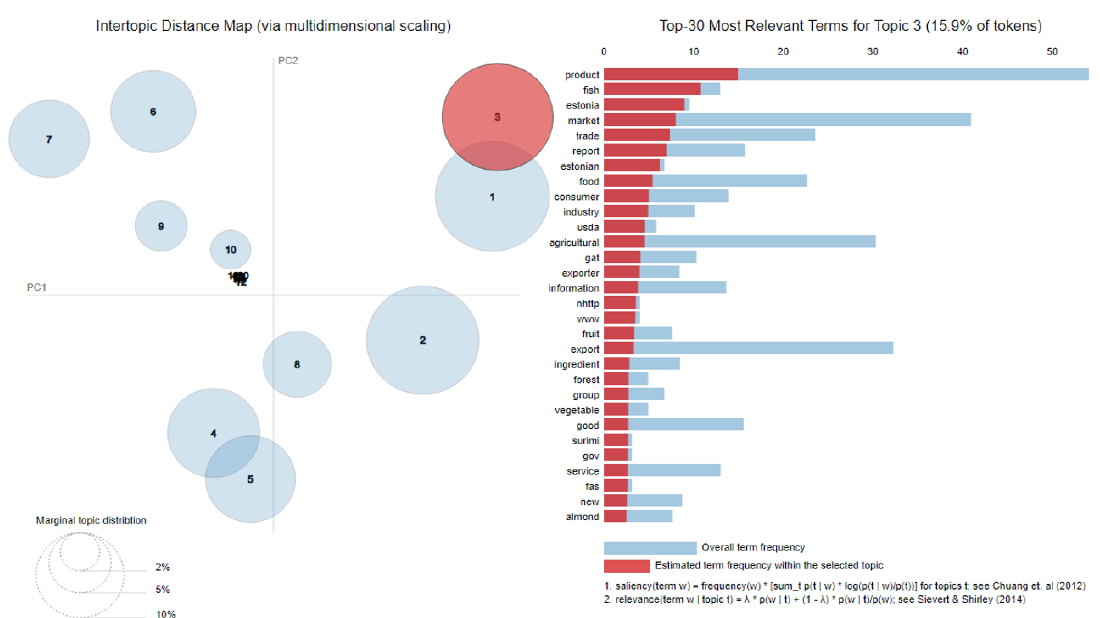
Figure 4. Lumber: Topic 3.